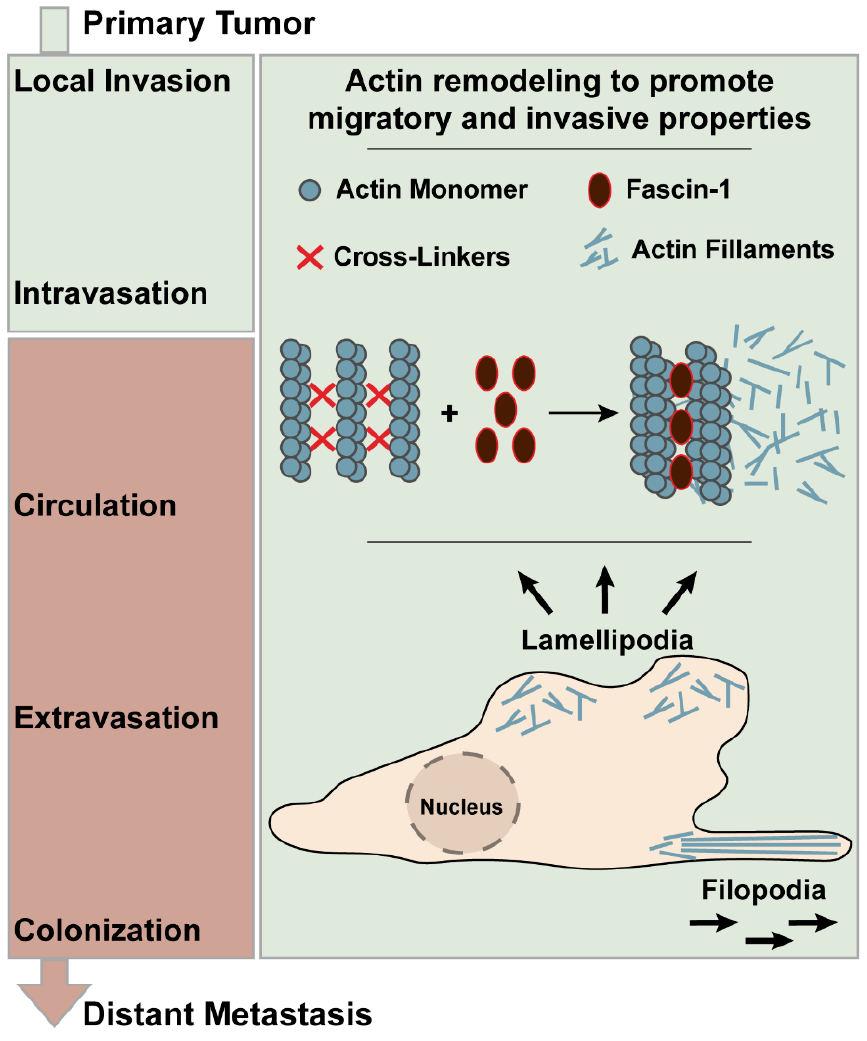
Figure 1. Metastatic progression of the primary tumor highlighting the role of fascin-1 in actin remodeling that promotes the invasive properties of cancer.